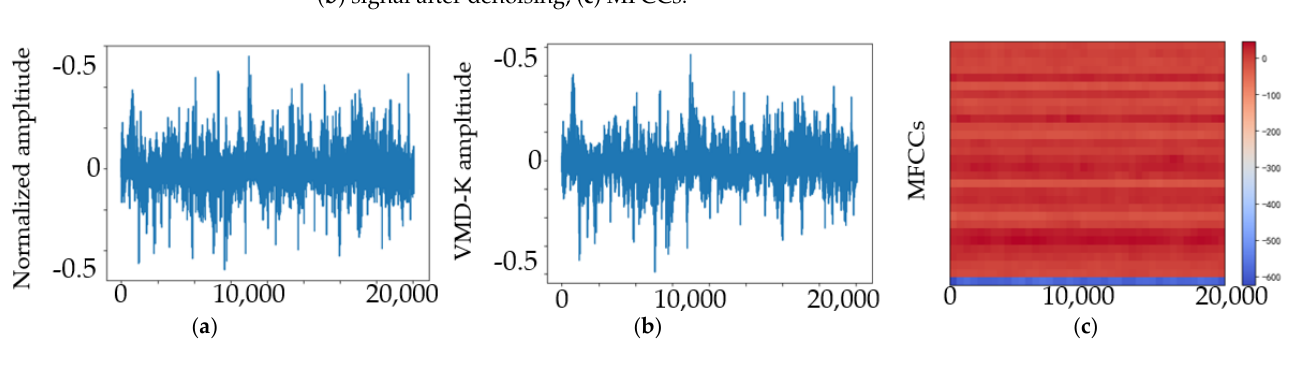
Figure 7. AE signals of the normal health state at 20 rpm and 100 kN radial load: ( a ) original signal; ( b ) signal after denoising; ( c ) MFCCs.